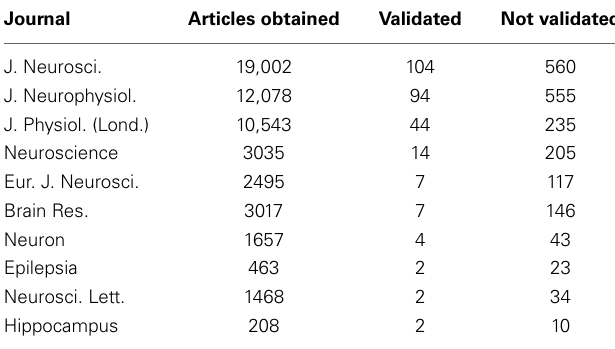
Table 1 | Statistics of journals represented in the NeuroElectro